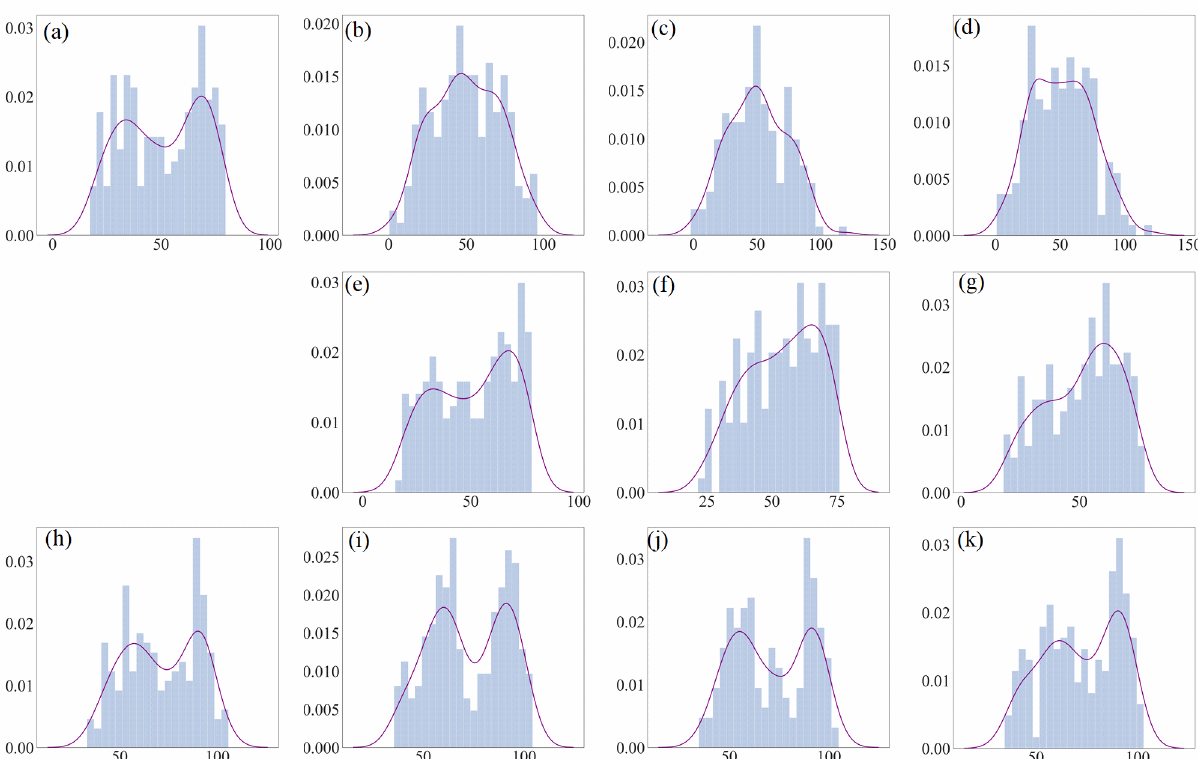
Figure A2. Changes in PDF during the successive adjustments of relative humidity based on the GCM MPI simulations at the Naqu site. The upper row indicates the control observations (( a ), 1955–1969)) and the calibrated results of the three adjustments ( b – d ). The center row ( e – g ) indicates the observations for validating the calibrated results for the corresponding projection periods. The bottom row ( h – k ) indicates the raw GCM simulations in the corresponding periods. The first column: control period (1955–1969); the second to fourth columns: the first (1970–1984), second (1985–1999) and third (2000 – 2014) adjustments, respectively. The solid line indicates a distribution fit to the data.